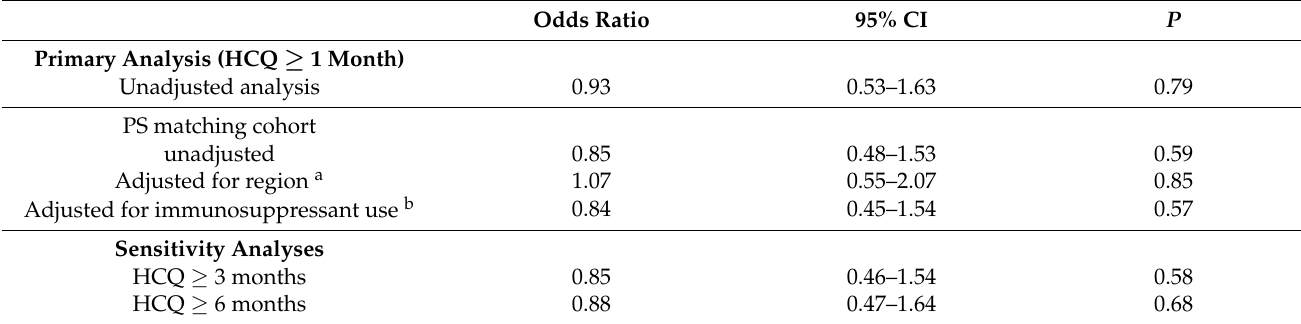
Table 4. Likelihood of positive test for SARS-CoV-2 according to treatment with HCQ among patients with rheumatic diseases. Odds Ratio 95%